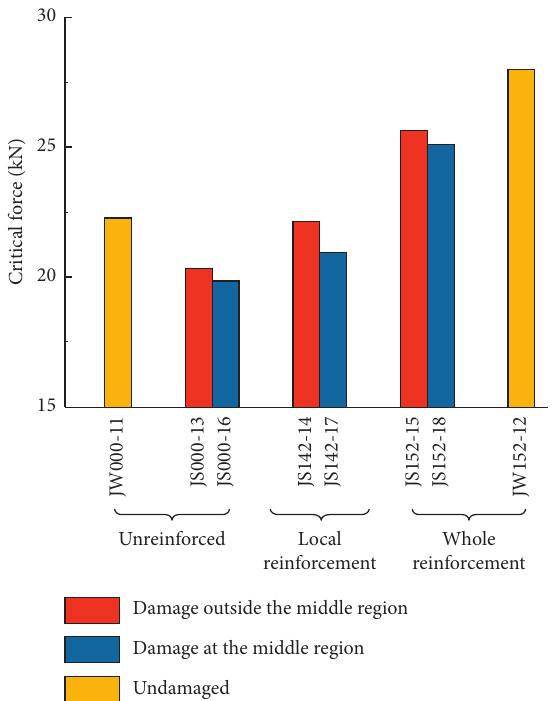
Figure 6: Influence of damage location on the critical force in Group 1.